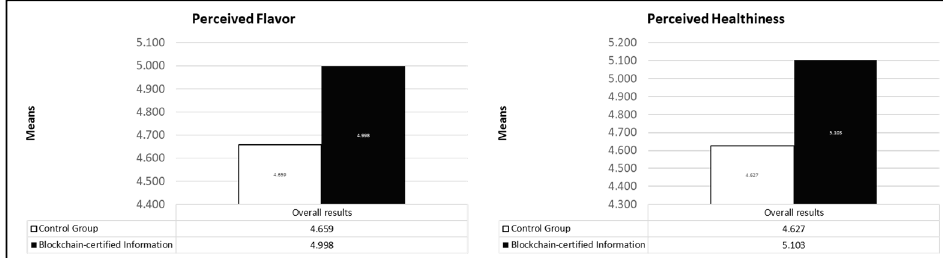
Figure 2. Adjusted mean by condition. Both differences are significant ( p <